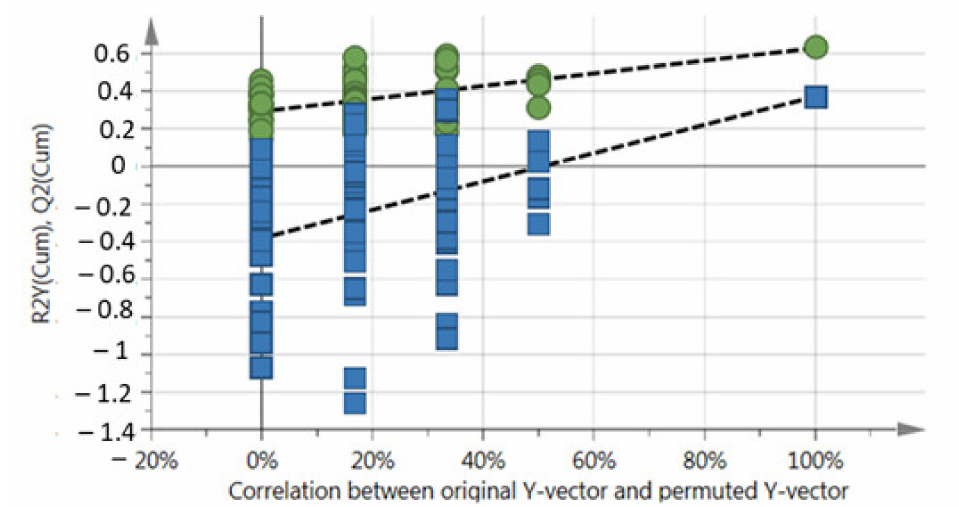
Figure 5. OPLS-DA model validity permutation test for M. oleifera (cultivar PKM1) metabolite profile under low, intermediate and high harvesting frequencies. Green circle–R 2 Y; blue square–Q 2